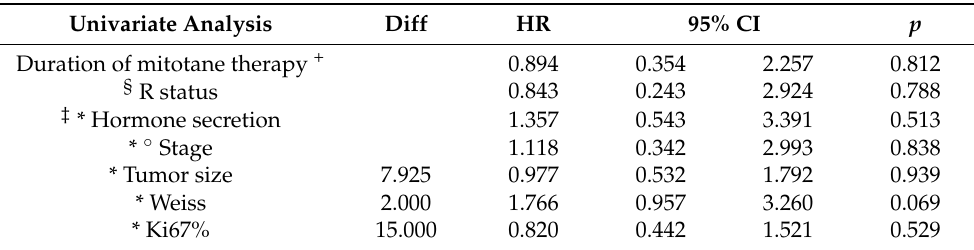
Table 5. Univariate analysis of predictive factors for recurrence free survival after adjuvant mitotane discontinuation (RFSAM). Univariate